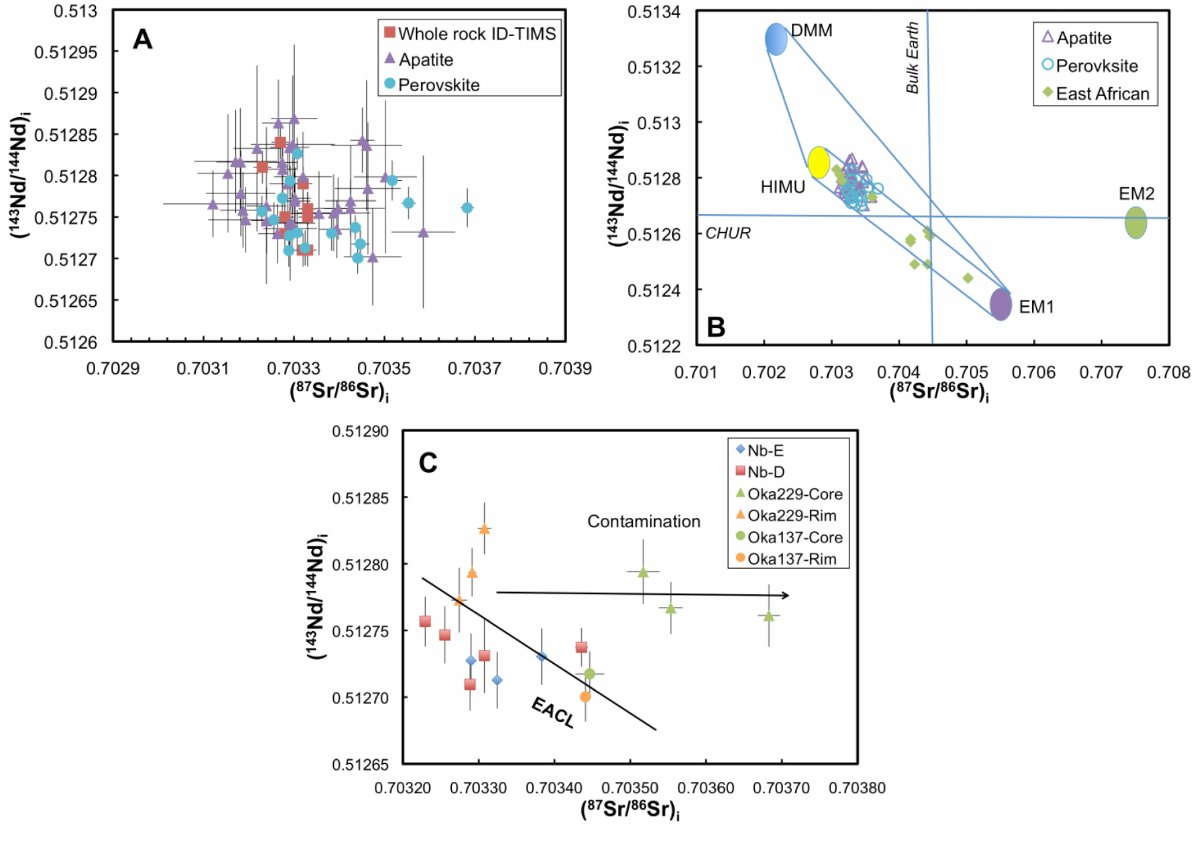
Carbonatite Line (EACL) from Bell and Blenkinsop [58], and CHUR and Bulk Earth (BE) values for comparison. ( C ) Diagram of 143 Nd/ 144 Nd vs. 87 Sr/ 86 Sr values for the different groups of